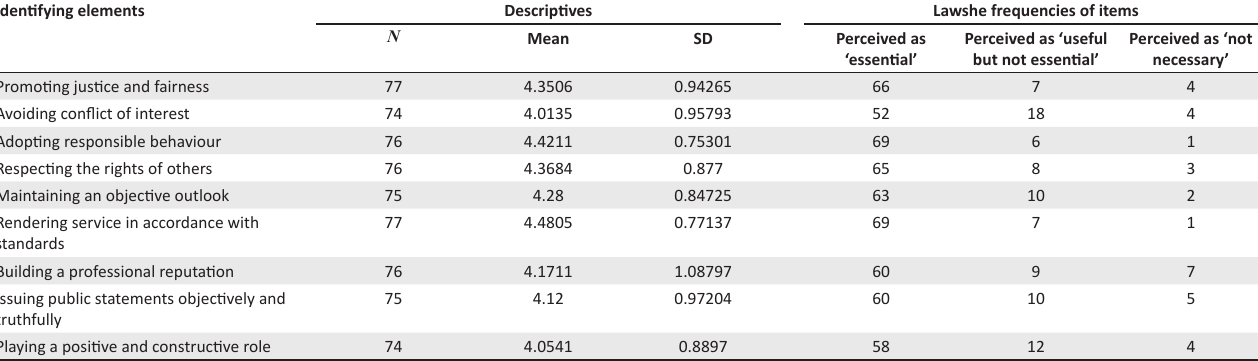
TABLE 13: Descriptive statistics of responsibility for personal work ethic. Identifying elements